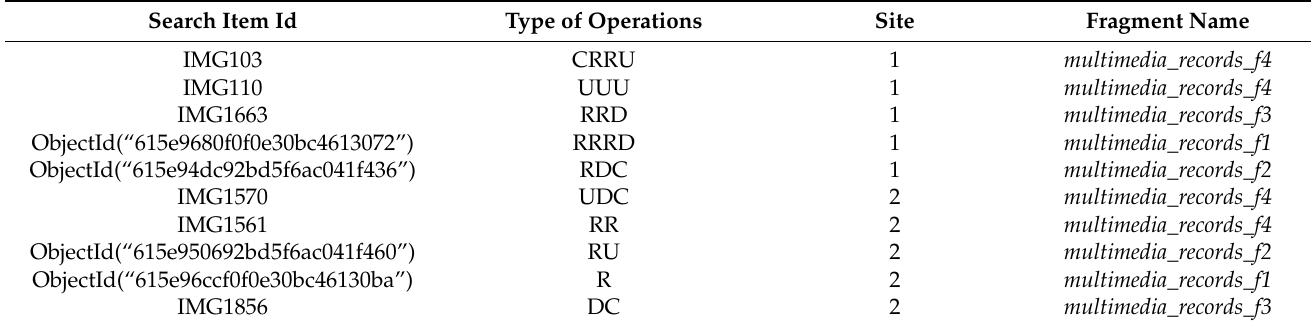
Figure 11. New values of operations and performance under the operations of Table 9. Table 10. Operations performed on the fragmented multimedia database in the new evaluation.